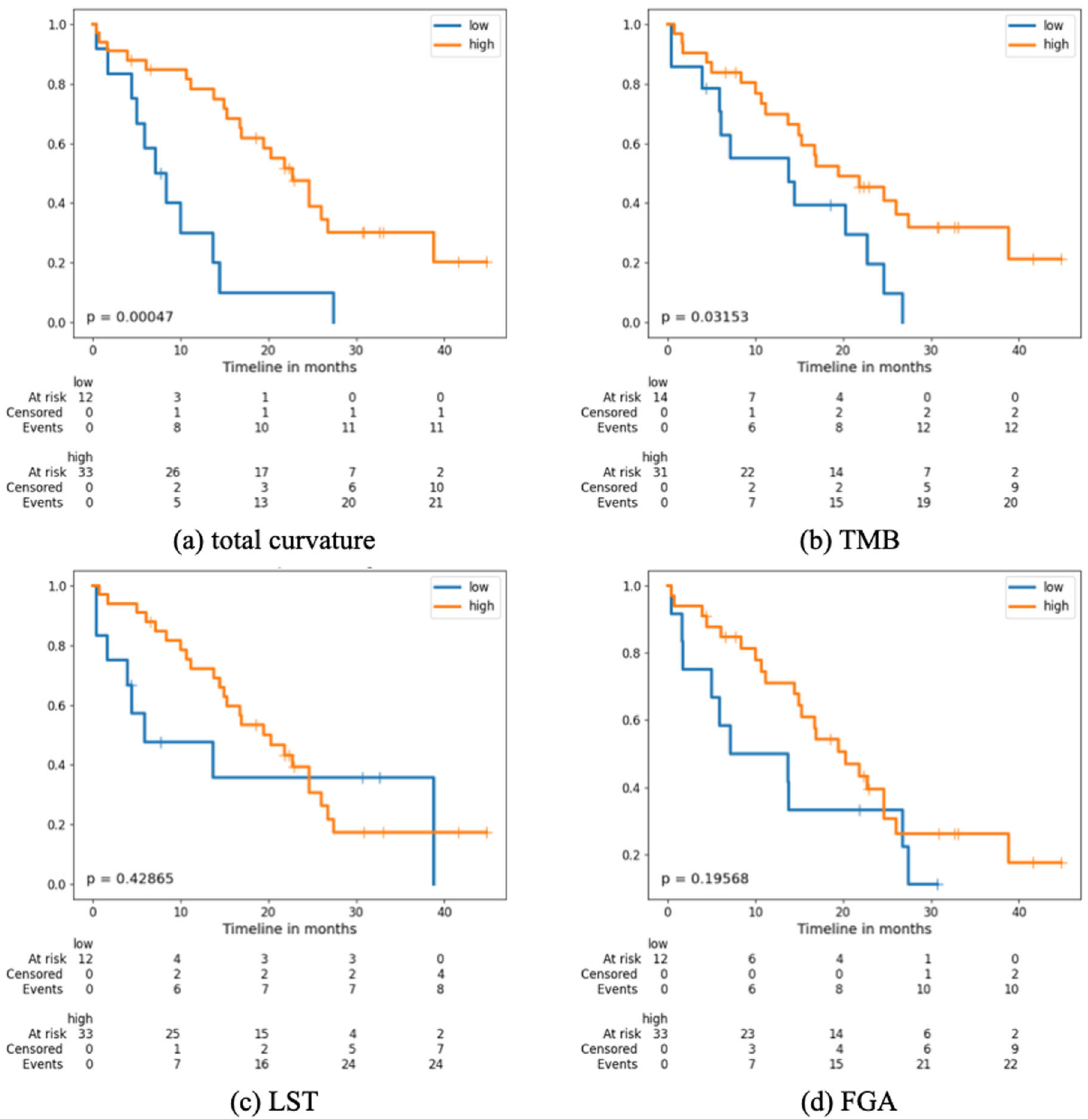
Fig. 1 Survival curves for HGSOC samples ( n = 45) strati fi ed low and high groups by the 25th percentile of total curvature and genomic parameters. P values were derived from the log-rank